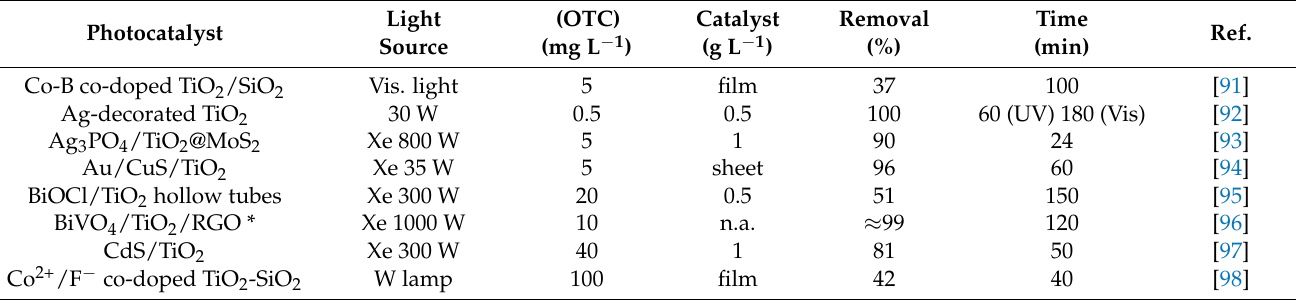
Table 2. OTC photodegradation over heterogeneous TiO 2 -based